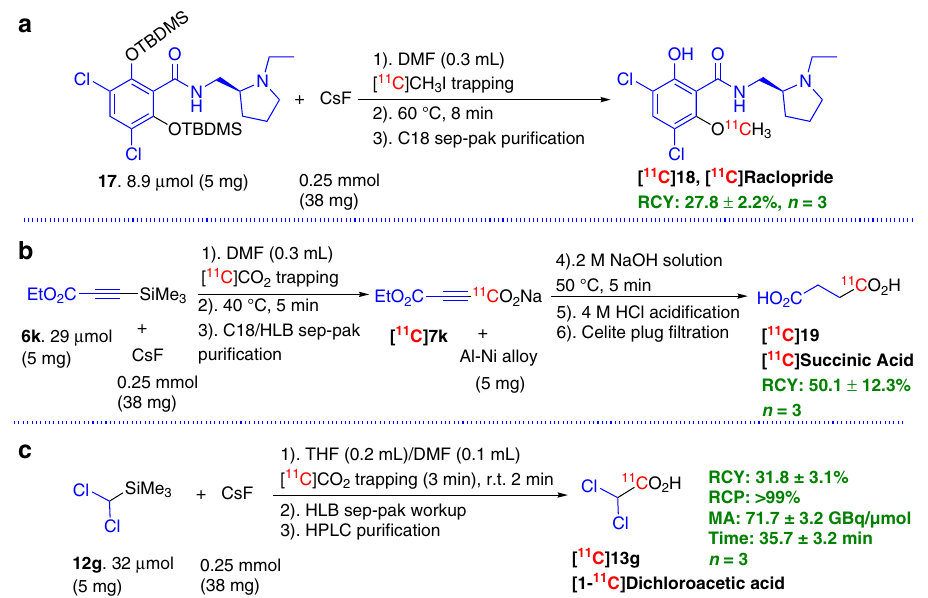
Fig. 6 Practical synthesis of three radiotracers via FMDS 11 C-labeling approach. a [ 11 C]raclopride synthesis via 11 C-methylation of dual TBDMS attached precursor 17 ; b [ 11 C]succinic acid synthesis via 11 C-carboxylation of alkylsilane 6k and Al-Ni alloy reduction of intermediate [ 11 C ] 7 ; c [ 11 C]dichloroacetic acid synthesis via 11 C-carboxylation of alkylsilane 12g